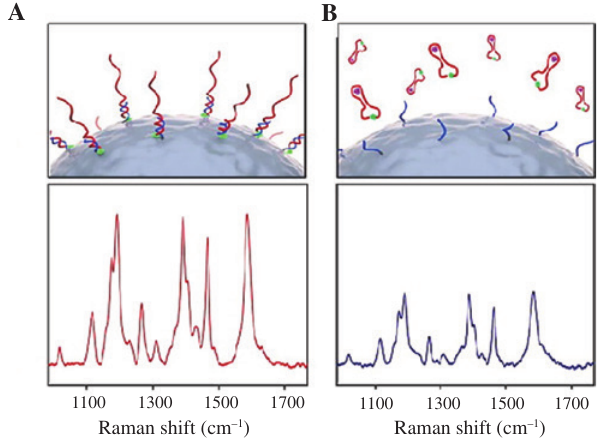
Figure 4: SERS spectra for (A) cy3-labeled aptamer double strand DNA-embedded Au/Ag core–shell NPs and (B) aptamer-detached Au/Ag core-shell NPs in the presence of 100 nm BPA. Adapted with permission from [160]. Copyright 2015